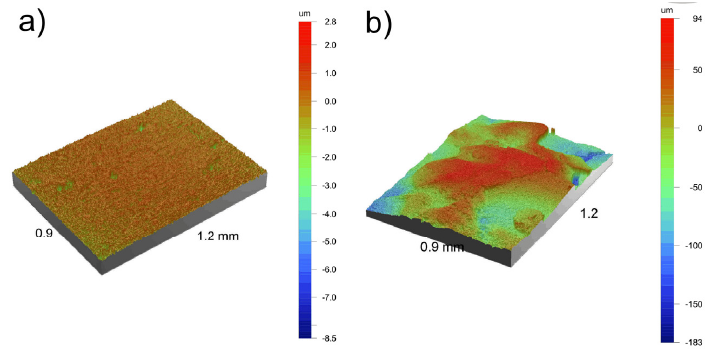
Figure 7. Optical profiler 3D topography of the Ti23Mo 3BG nanocomposites before ( a ) and after electrochemical etching with additional Ca-P deposition ( b ); 0.9 mm ˆ 1.2 mm scan size.